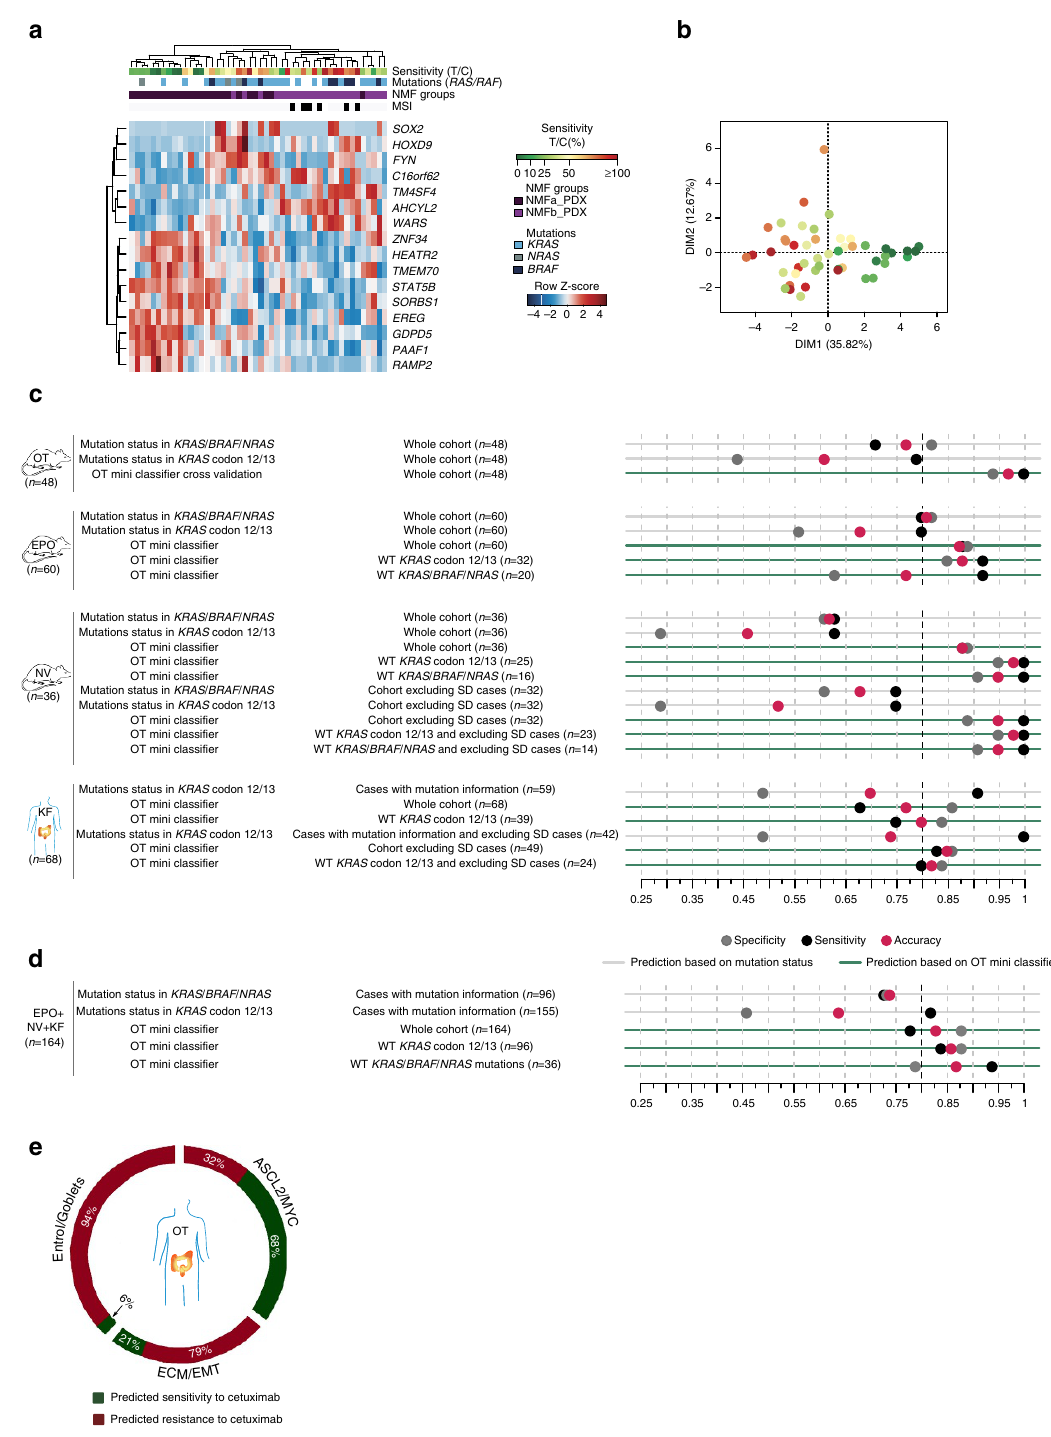
Figure 10 | Validation of the mini-classifier of cetuximab response in PDX. The drug sensitivity is given by T/C continuous values coloured as indicated in the caption (dark green: strong response, red: resistance). MSI samples, OT-NMF-groups, CMS classification and mutations are coloured as indicated in the caption. ( a ) Hierarchical clustering of 48 PDX samples based on the mini-classifier ( n ¼ 16 genes) obtained by SVM-based machine learning. ( b ) Principal component analysis (PCA) showing the classifier’s ability to separate responders from non-responders. ( c ) Respective performances of the OT mini-classifier and of the RAS/RAF mutation status in predicting cetuximab sensitivity in the following cohorts OT-PDX (OT) (cross-validation), EPO PDX, the Gao et al. , 12 PDX (NV) and Khambata-Ford et al. , 46 primary tumours (KF). The mutation status was defined by mutations in codon 12 and 13 of KRAS or detected activating mutations in KRAS , BRAF or NRAS ( BRAF mutations: V600E; KRAS/NRAS mutations: G12, G13, Q22, Q61, A146). In an additional setup, stable disease (SD) samples were excluded. The dot plot shows the specificity, sensitivity and balanced accuracy of the predictions. The 0.8 value is highlighted.with a black dotted line. ( d ) Same as in ( c ) but taking as validation cohort 164 samples merged from OT, EPO, NVand KF. ( e ) Distribution of the predicted responders and resistant patient tumours (tumour purity Z 40%) in the three molecular groups (ECM/EMT, ASCL2/MYC,